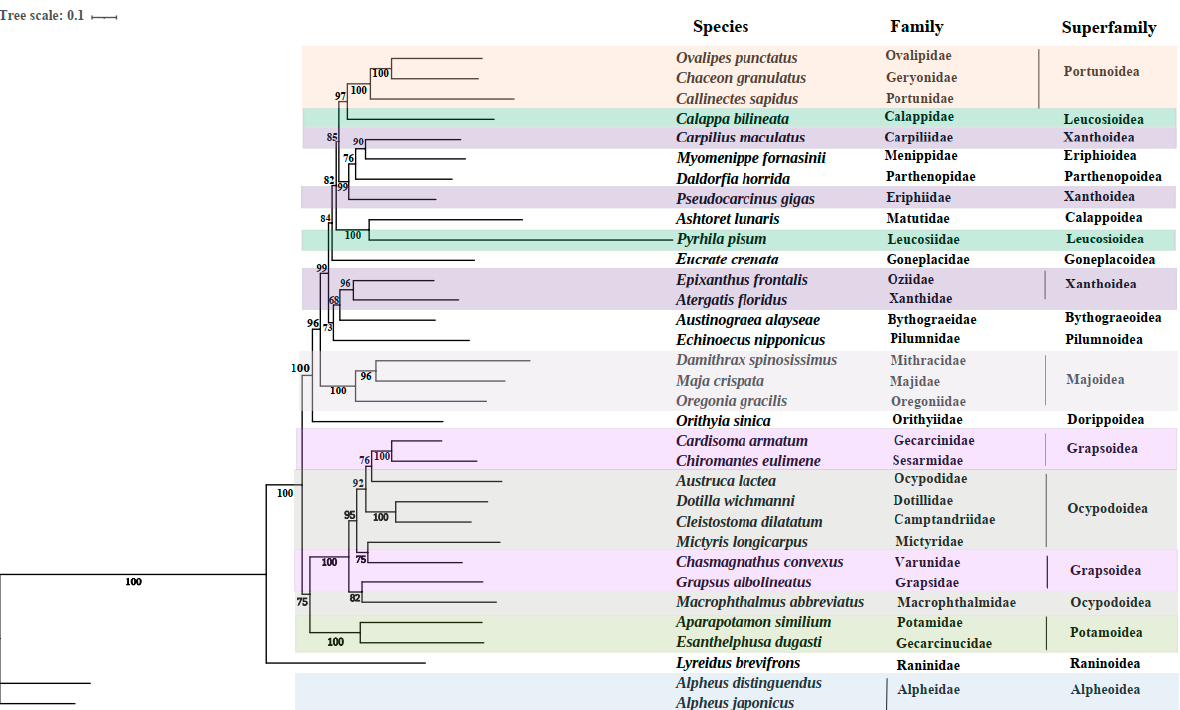
Figure 3. Phylogenetic tree derived from Maximum likelihood (ML) analysis based on nucleotide sequences of 13 mitochondrial PCGs ( atp6 , atp8 , cox1 , cox2 , cox3 , cob , nad1 , nad2 , nad3 , nad4 , nad4L , nad5 and nad6 ). Species belonging to the same superfamily are marked with the same color. Numbers on branches represent ML bootstrap values.